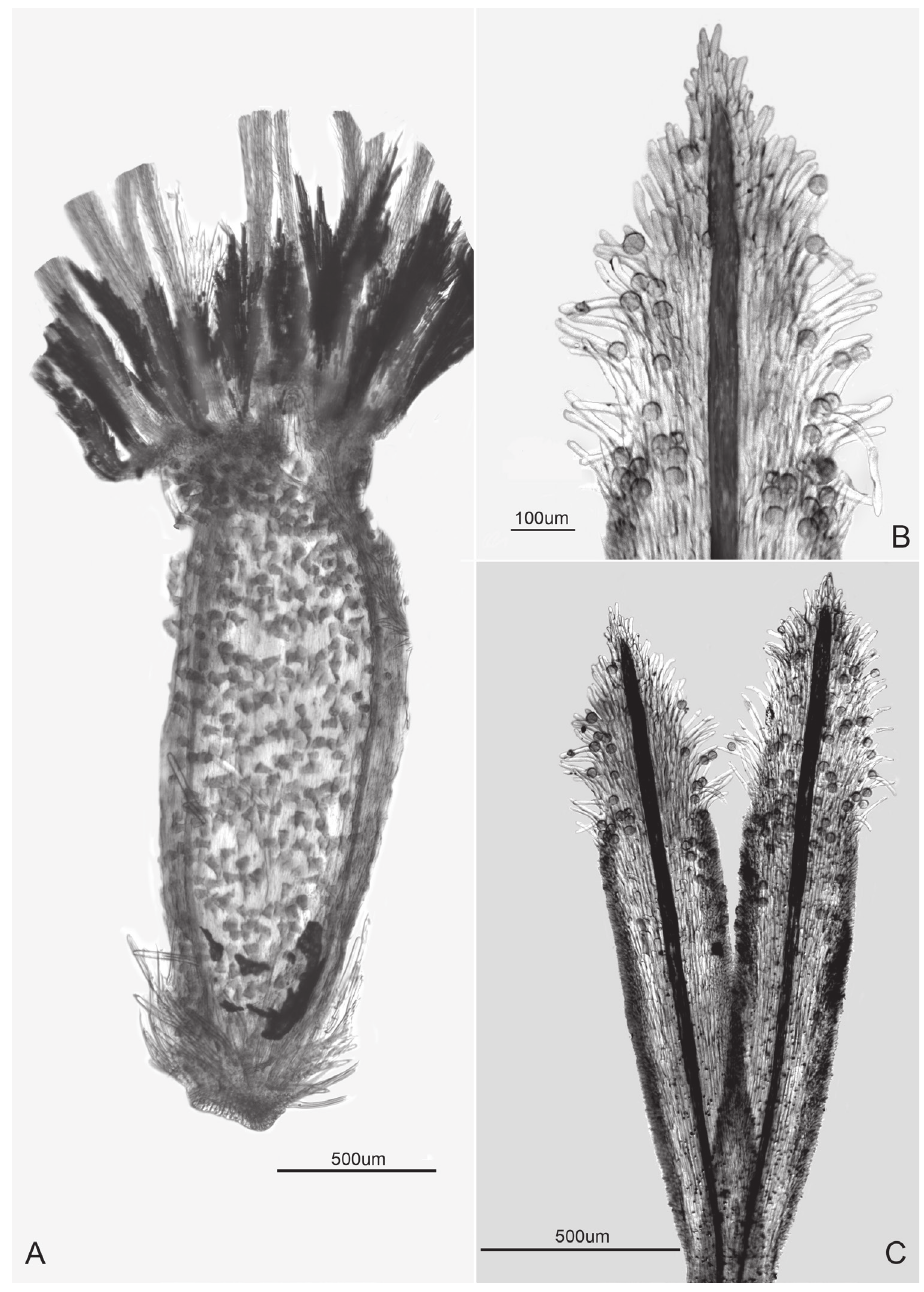
Figure 2. Floral details of Dysaster cajamarcensis H. Rob. & V.A. Funk A Disc achene B Style appendage C style branches showing stigmatic lines and